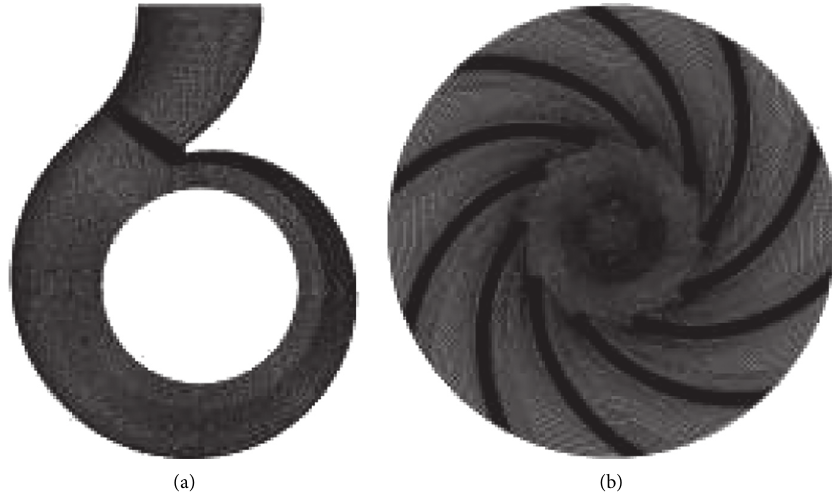
Figure 3: Sketch of the structured mesh: (a) volute; (b) impeller.